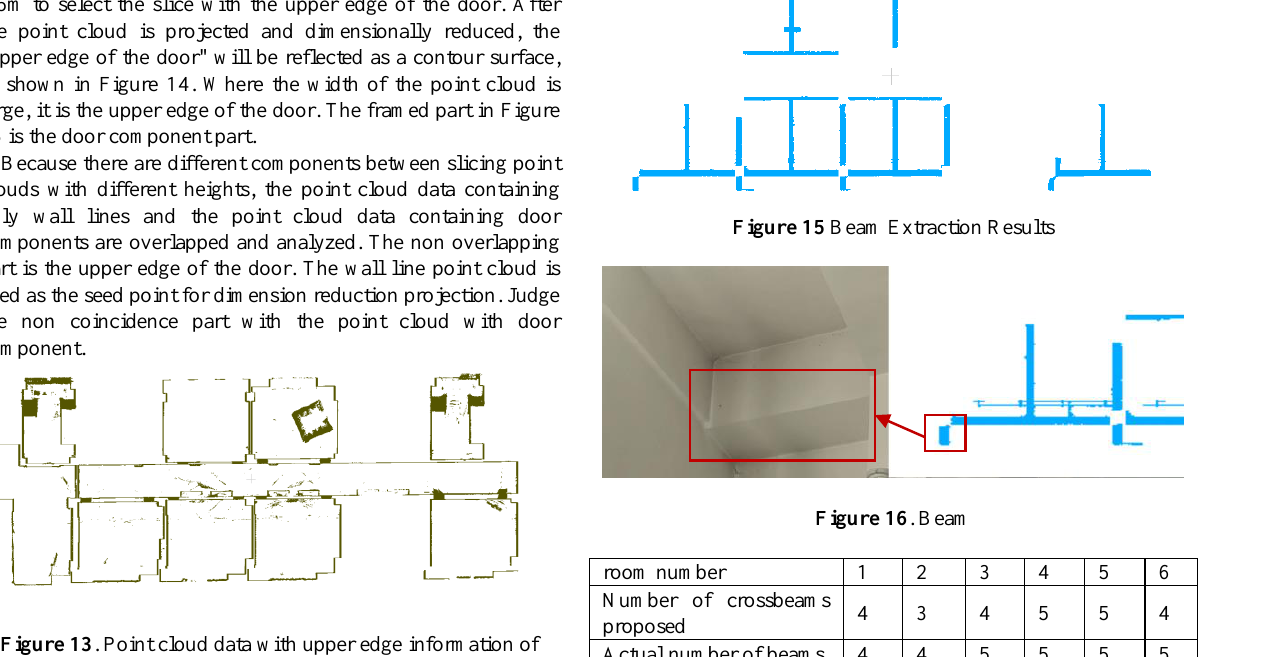
Figure 13 . Point cloud data with upper edge information of